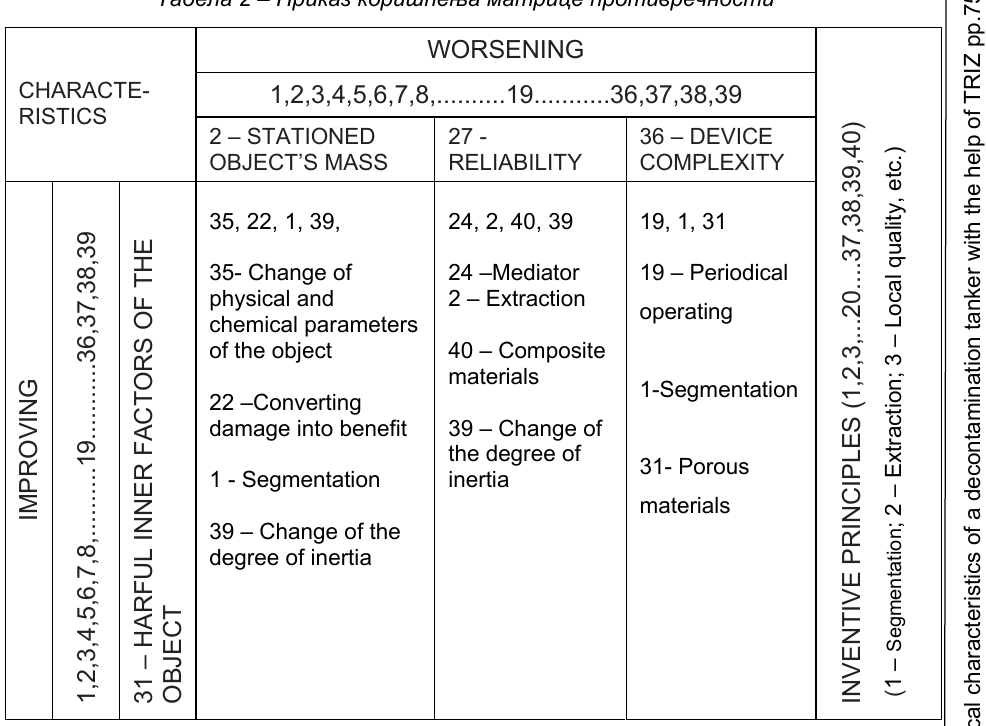
Таблица 2 – Применение матрицы противоречий Табела 2 – Приказ коришћења матрице